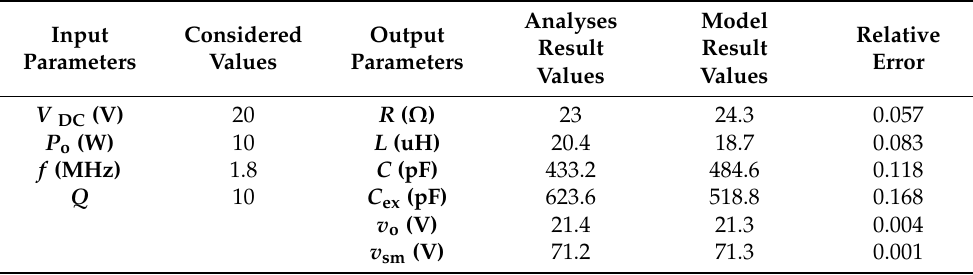
Figure 11. Class-E circuits simulation using extracted circuit parameters from analyses (solid line) and the proposed model (dashed line). Table 8. A comparison between the final model and analysis results of the presented design example at 1.8 MHz.